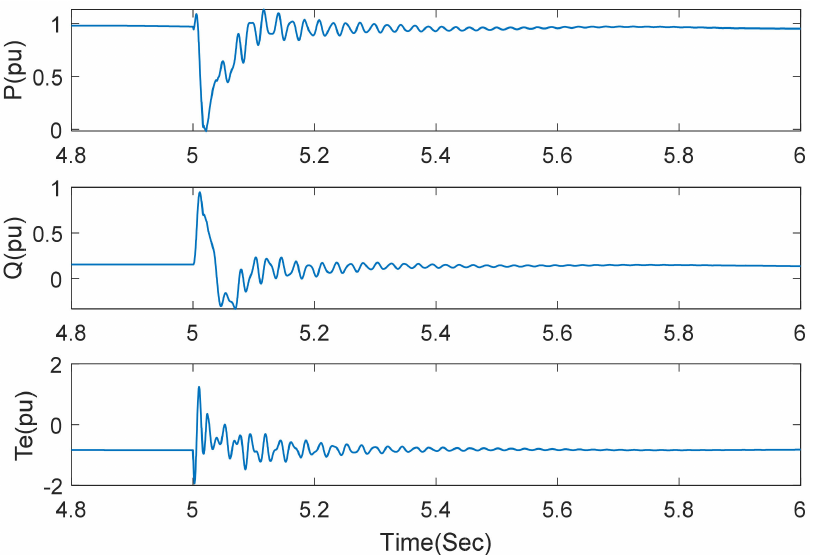
Figure 8. Dynamic responses of active power, reactive power, and electromagnetic torque under three-phase short circuit fault.